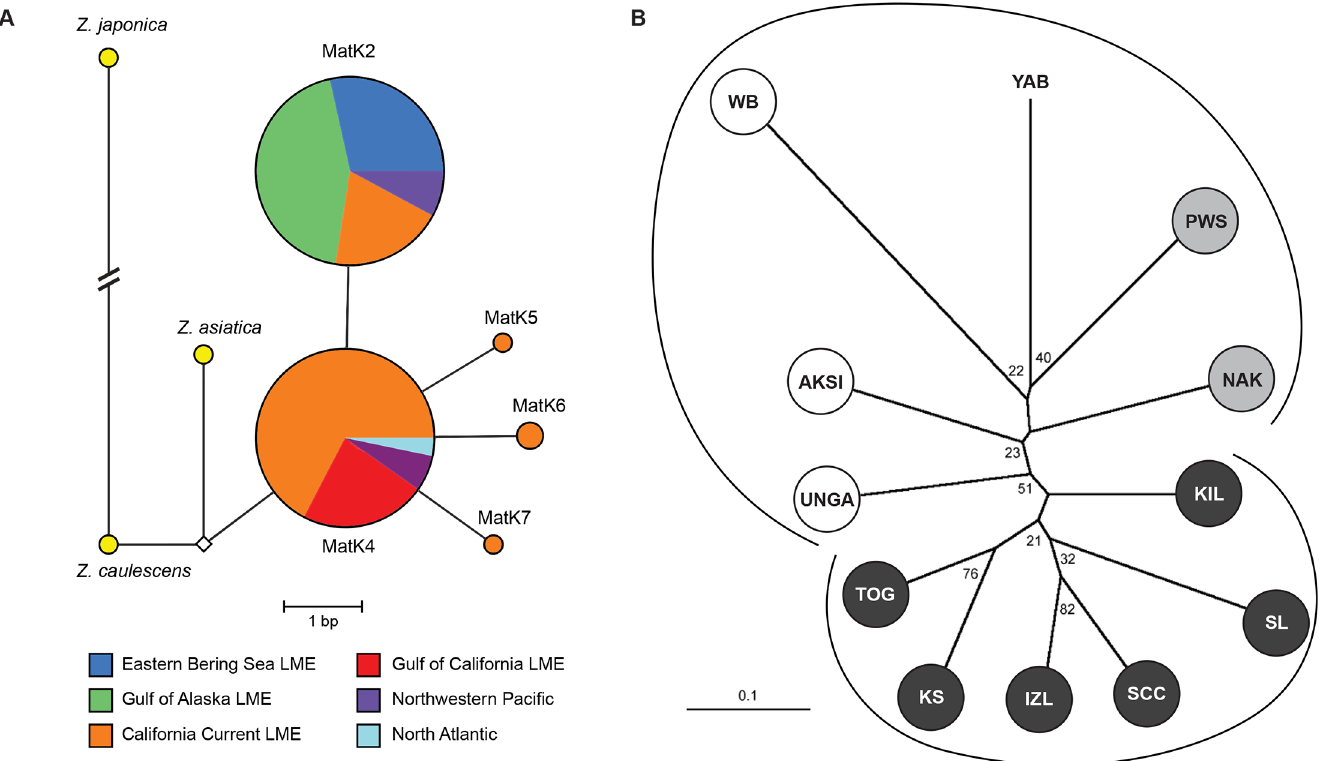
Fig 3. (A) Parsimony network of chloroplast mat K haplotypes from Z . marina and (B) a neighbor-joining tree illustrating relationships among Pacific coast populations of Z . marina . (A) A parsimony network of chloroplast mat K haplotypes assayed from Z . marina from the EBS-LME (n = 29), GoA-LME (n = 45), CC-LME (n = 86), and GoC-LME (n = 21). Data are from populations listed in S1 Fig, along with homologous data reported elsewhere [62,96] for samples collected from various locales within the CC-LME (GenBank accessions: mat K2 — EF19834, AB125354, AB096164; mat K4 — EF1983339, EF198342, AB125356, AB125355). Homologous data from Z . marina from the Northwest Pacific (Japan and Korea; n = 14, data from [16,62]), the North Atlantic (Germany, n = 2, GenBank accessions: JN225374-75; Ukraine, n = 1, GenBank accession: JQ990925), and one sample each from Z . japonica (GenBank accession: AB125361), Z . caulescens (GenBank accession: AB125358), and Z . asiatica (GenBank accession: AB125360) are included for comparison. The size of the node corresponds to the frequency of each haplotype within each LME or region, and length of branch corresponds to number of changes, unless noted with diagonal slant bars. The small white diamond indicates an intermediate ancestral allele that was not sampled. (B) Neighbor- joining tree illustrating relationships among Pacific coast populations of Z . marina . D CE distances were generated by data from 10 microsatellite loci. Bootstrap values (2000 replications) are listed at the node. Black, white, and gray circles identify populations belonging to the three discrete groupings (Model D) uncovered via AMOVA analyses to reflect significant and highest allelic variance at the regional level (see Results, in text, and S1 Table).